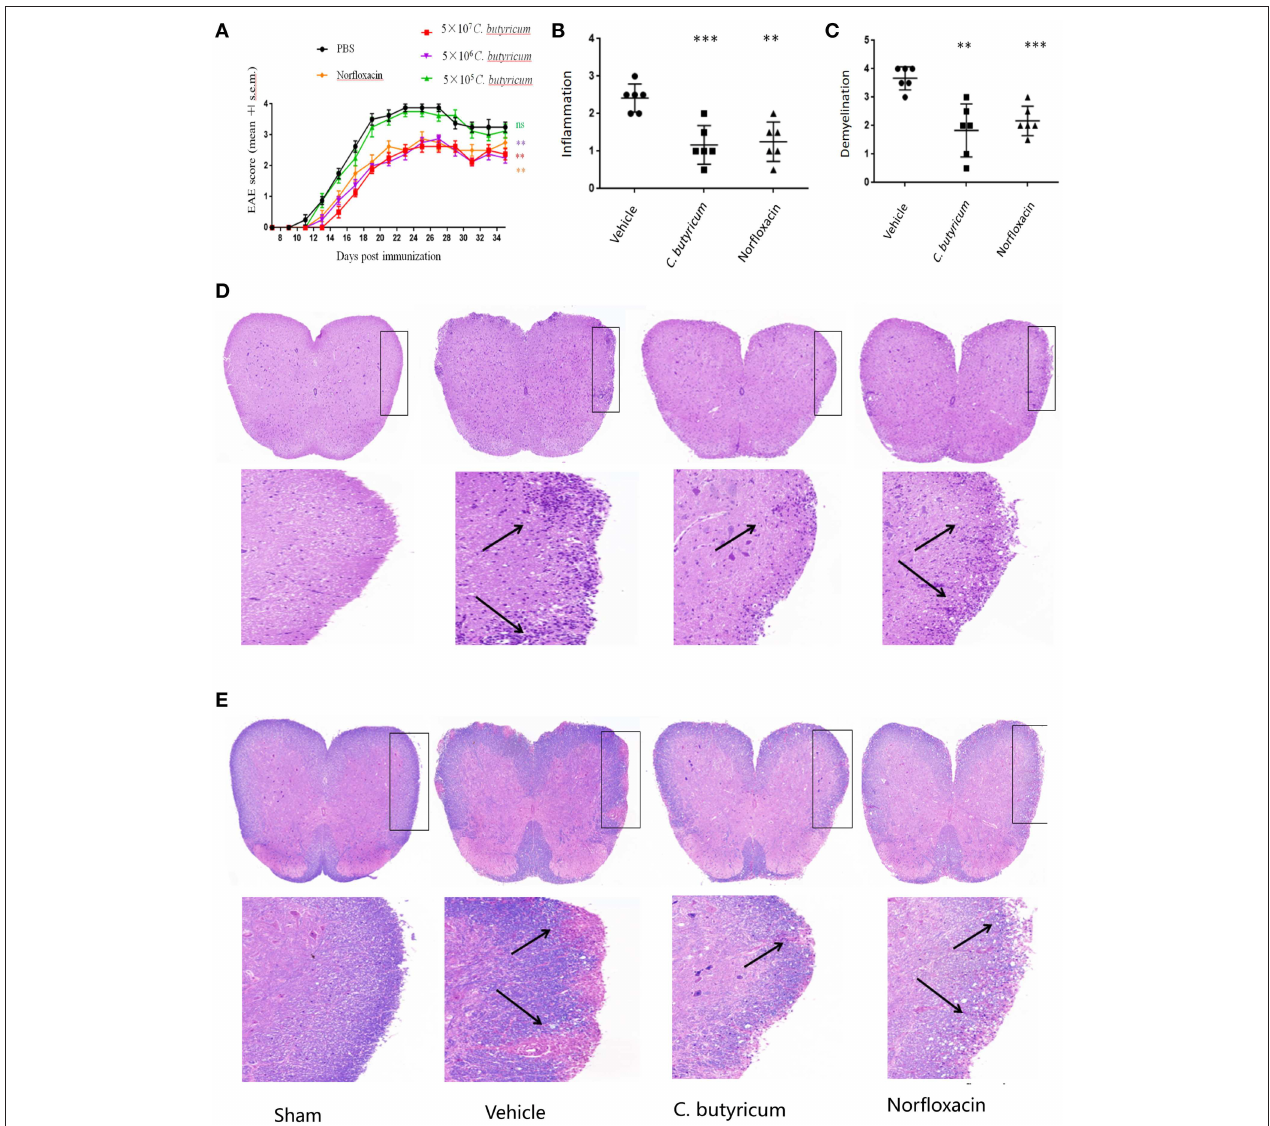
FIGURE 1 | C.butyricum and norfloxacin treatment both ameliorated clinical severity and neuropathology of EAE mice. (A) Clinical score was assessed daily and shown ( n = 8). (B–E) At 21 days post immunization, lumbosacral spinal cords were isolated and performed H&E ( n = 6) (D) or Solochrome cyanin impregnation (E) staining for assessment of histopathology. Representative sections (D,E) and statistical analysis (B,C) data are shown. The infiltration of lymphocytes and demyelination are highlighted by arrow. Experiments were repeated three times with similar results. Statistically significant data are indicated by asterisks (** P < 0.01 and *** P <